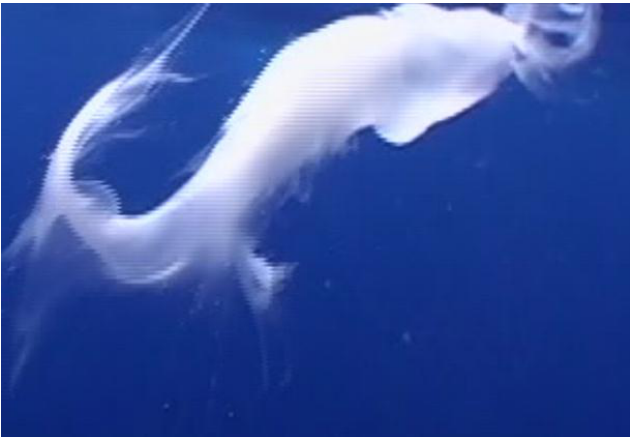
Figure 2. Free floating milk during observation of Focal Group 2.